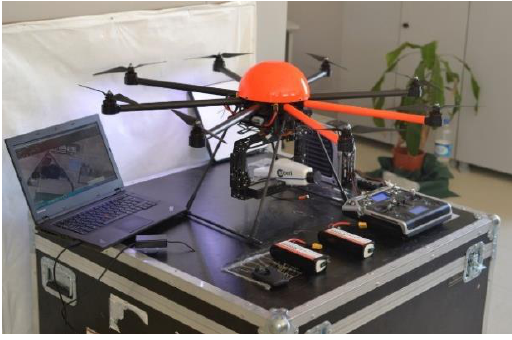
Figure 8. Octocopter with mounted hyperspectral camera